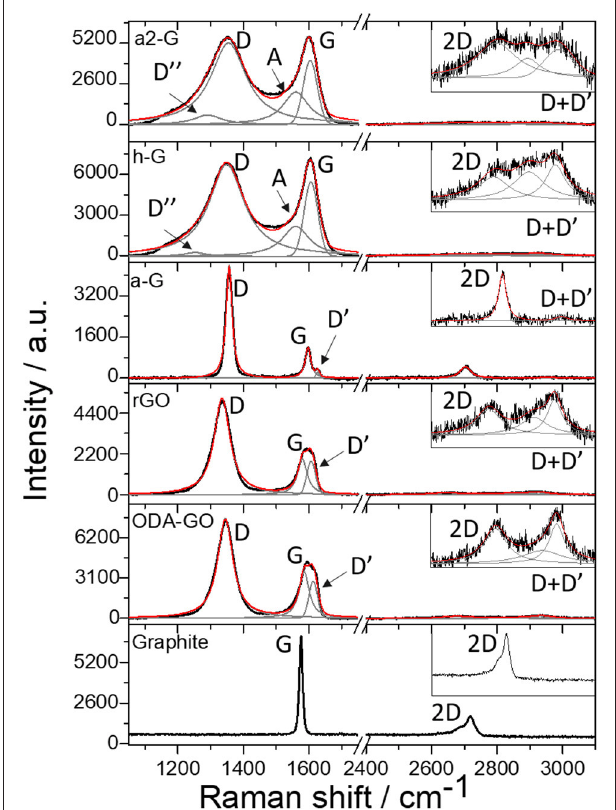
FIGURE 4 | Raman spectra of the studied samples. The black lines represent the raw spectra, the gray lines correspond to the individual distributions used for the fitting procedure and the red line is the cumulative fitting curve. Notations for all the encountered vibrational modes can also be seen.